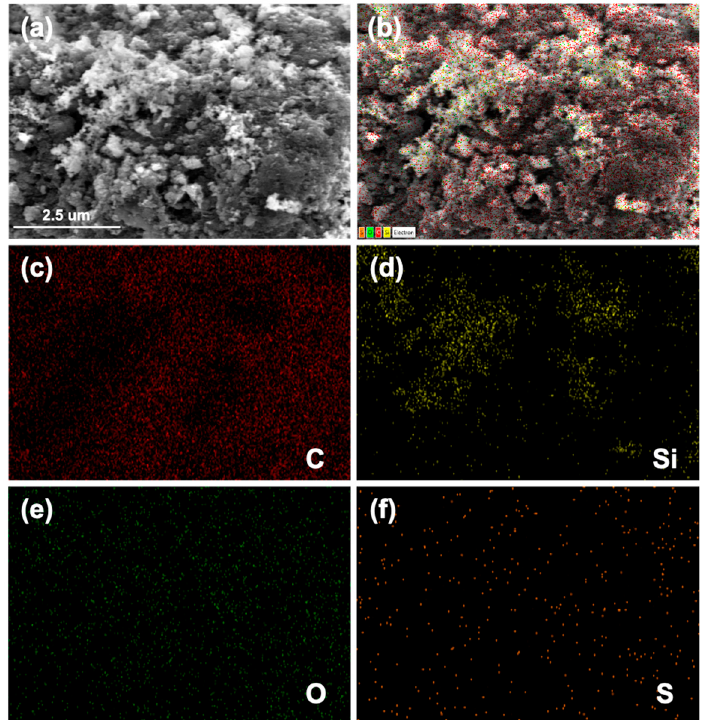
Figure 3. ( a ) SEM image of Si-graphene; EDS mapping of Si-graphene ( b ), element C ( c ), element Si ( d ), element O ( e ), and element S ( f ).